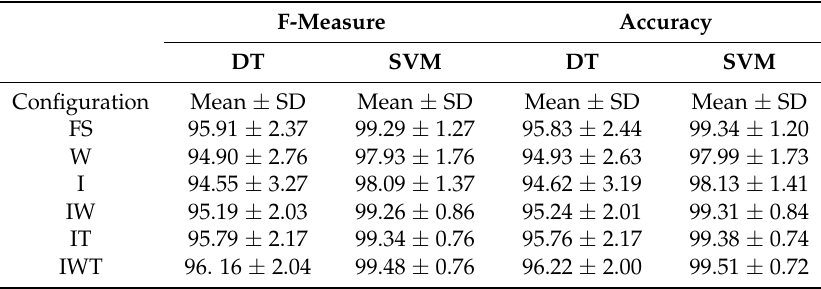
Table 2. Average F-measure (%) and accuracy (%) of personal analysis.